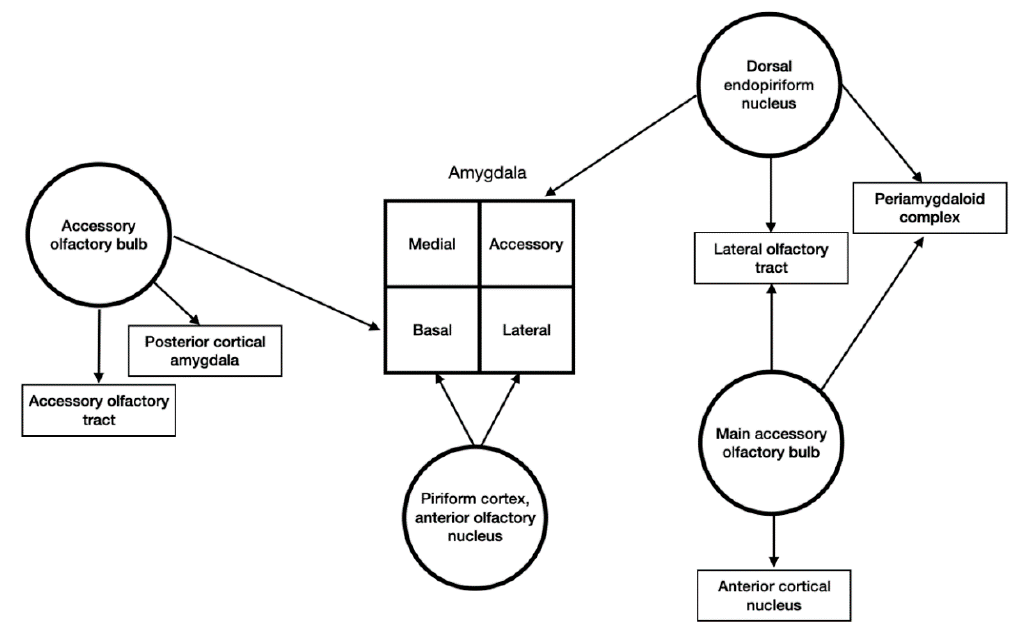
Figure 2. Schematic representation of olfactory sensory input to the amygdala.